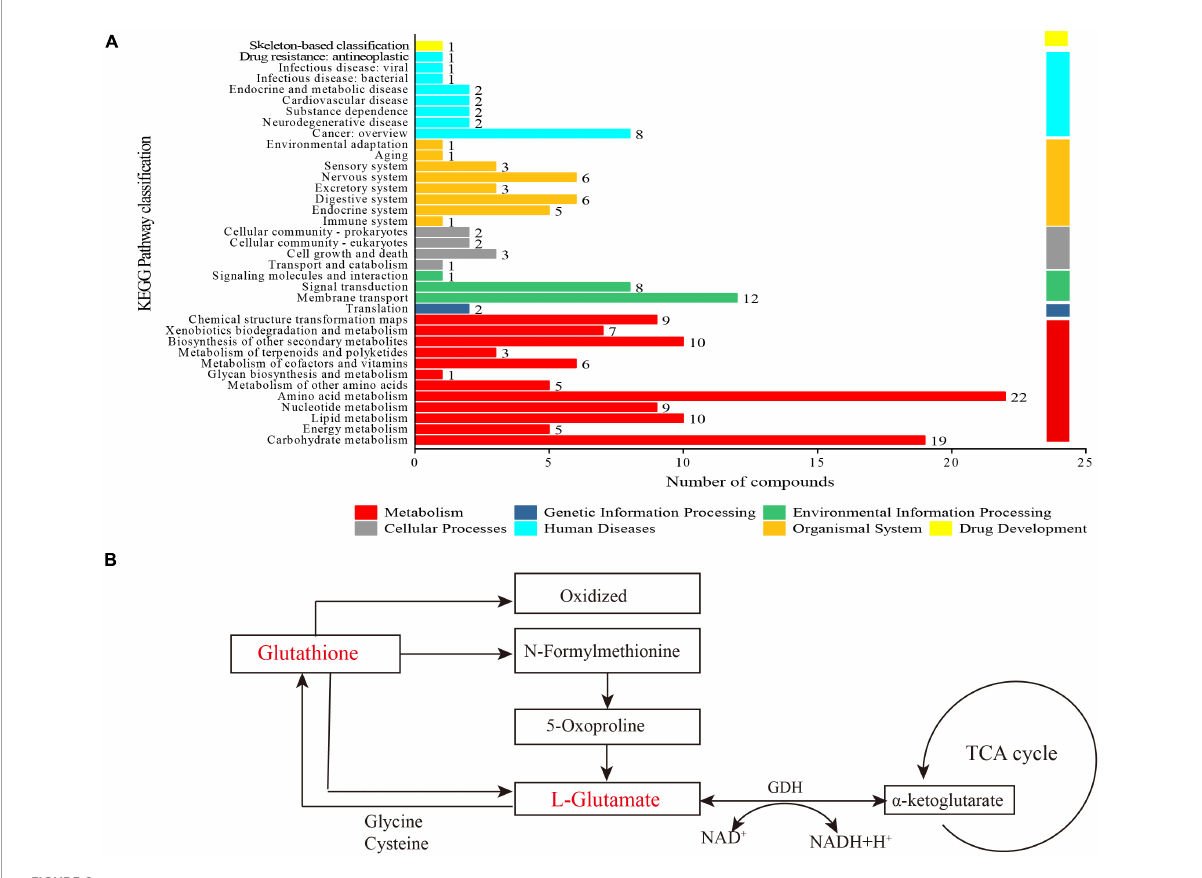
FIGURE6 Metabolic pathways analysis. (A) Kyoto Encyclopedia of Genes and Genomes (KEGG) metabolite statistics; (B) schematic diagram of the metabolic pathway for the selected